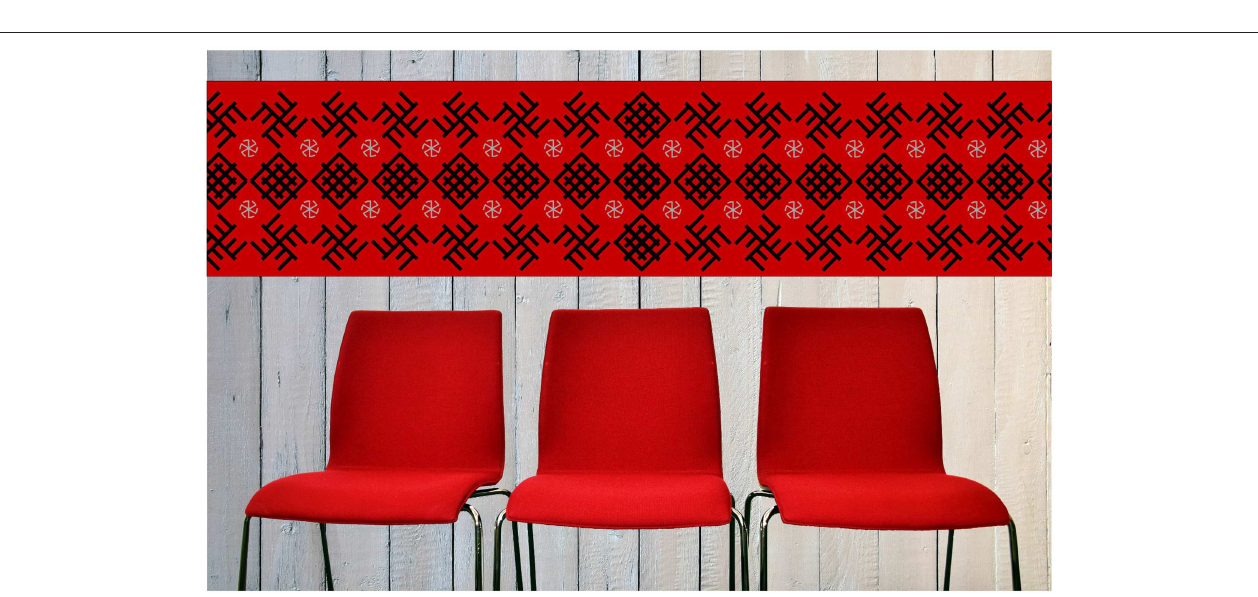
FIGURE 11 | An example of the metamaterial panel in a room (thanks to “https://pixnio.com” for an original image).